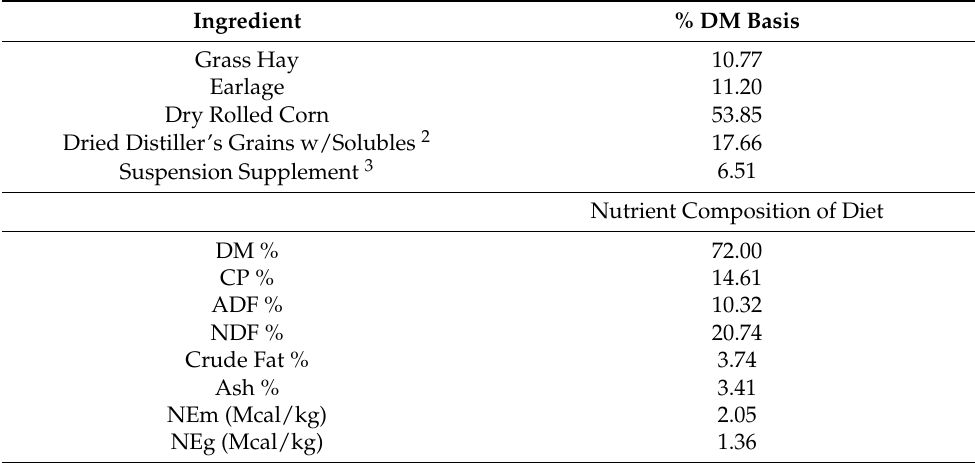
Table 2. Dietary components and nutrient composition of finishing diet 1 consumed by offspring of cows receiving a forage-based or concentrate-based diet during mid- and late-gestation. Ingredient % DM Basis Grass Hay 10.77 Earlage 11.20 Dry Rolled Corn 53.85 Dried Distiller’s Grains w/Solubles 2 17.66 Suspension Supplement 3 6.51 Nutrient Composition of Diet